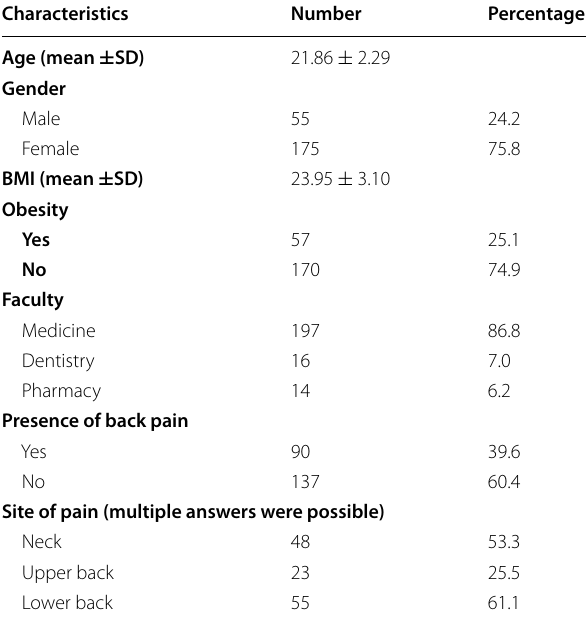
Table 1 Sociodemographic characteristics of the study sample ( N =